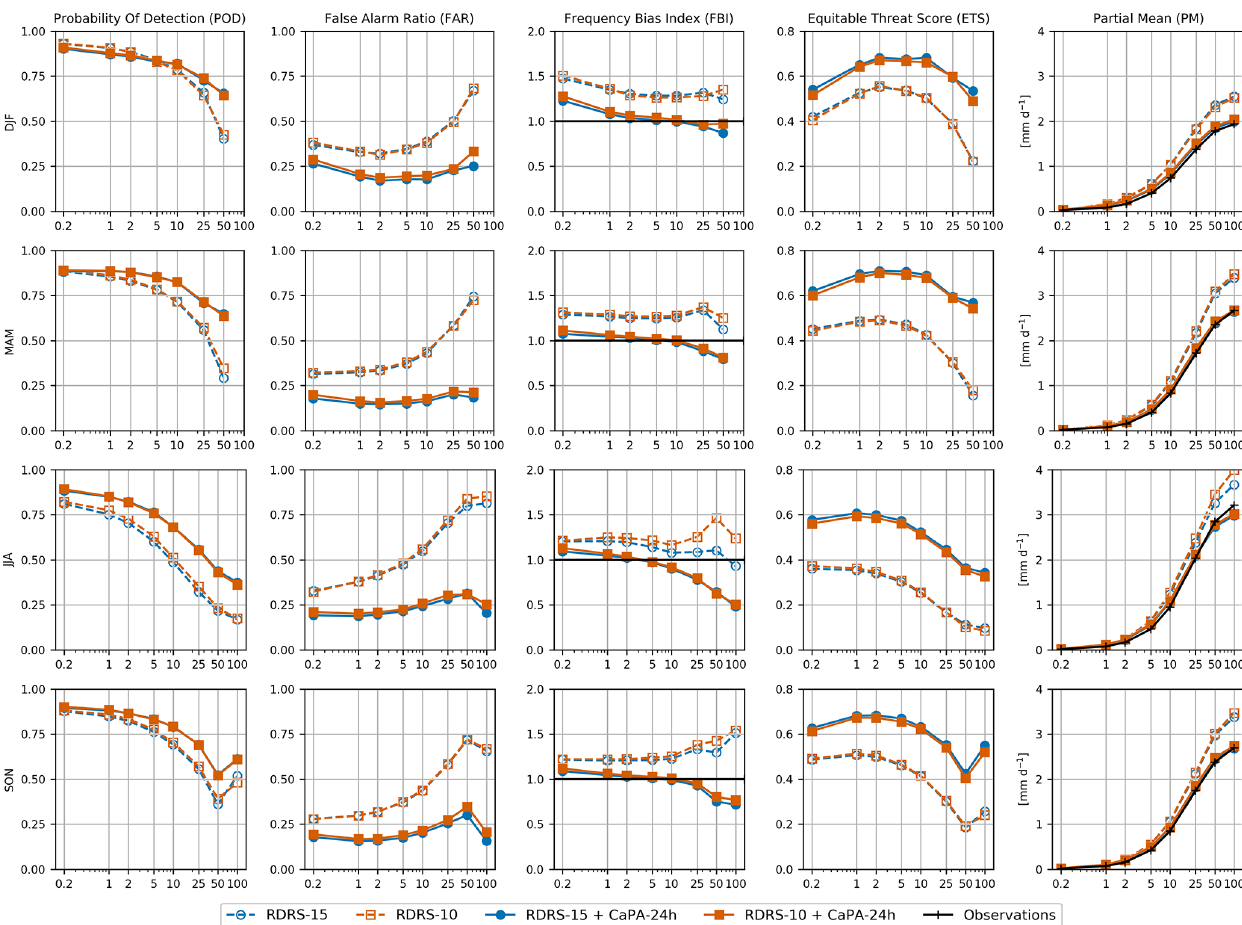
Figure 9. Comparison of CaPA-24h background field (dashed lines) and analyses (continuous lines) at 10km (orange lines) and 15km (blue lines) against manual synoptic stations over years 2010–2014. Each row corresponds to a season (winter, spring, summer and autumn) and each column to a score (probability of detection, false alarm ratio, frequency bias index, equitable threat score and partial mean). The x axis is the precipitation threshold [mmd − 1